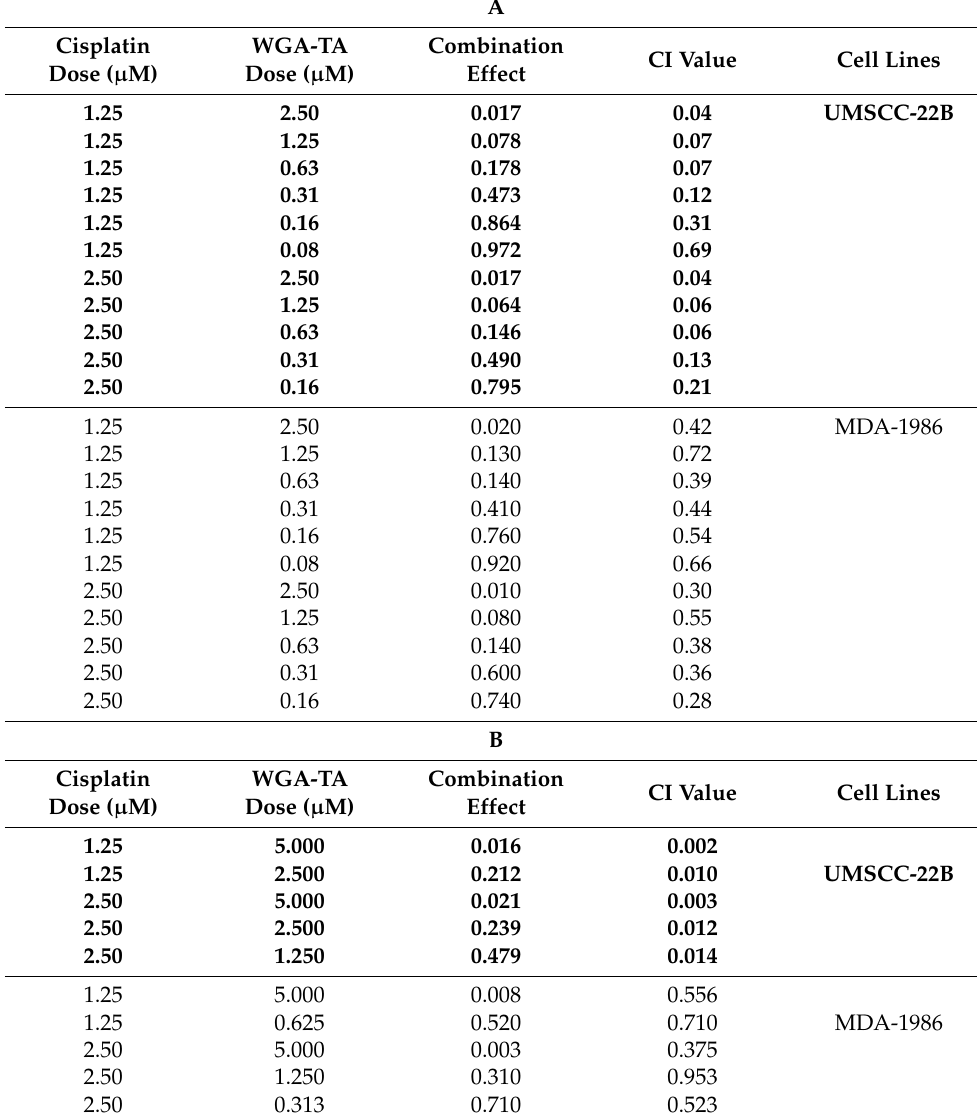
Table 1. ( A ) 1 MDA-1986 and UMSCC-22B (in bold) cells were treated with cisplatin and WGA-TA, and the cell viability was determined by MTS assay after 72 h. The combination index (CI) values were calculated using CompuSyn. CI < 1.0 is synergistic, CI = 1 is additive, and CI > 1.0 is antagonist. ( B ) 1 MDA-1986 and UMSCC-22B (in bold) cells were treated with cisplatin and WGA-TA and the cell viability was determined by MTS assay after 24 h. The combination index (CI) values were calculated using CompuSyn. CI < 1.0 is synergistic, CI = 1.0 is additive, and CI > 1.0 is antagonist. A Cisplatin WGA-TA Combination CI Value Cell Dose ( µ M) Dose ( µ M) Effect